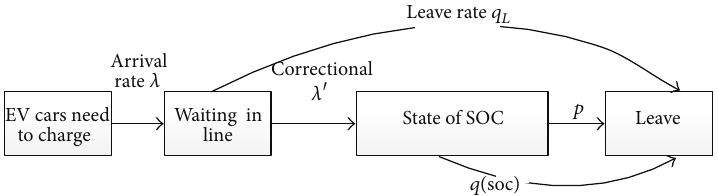
Figure 5: The correctional diagram of EVs’ charging